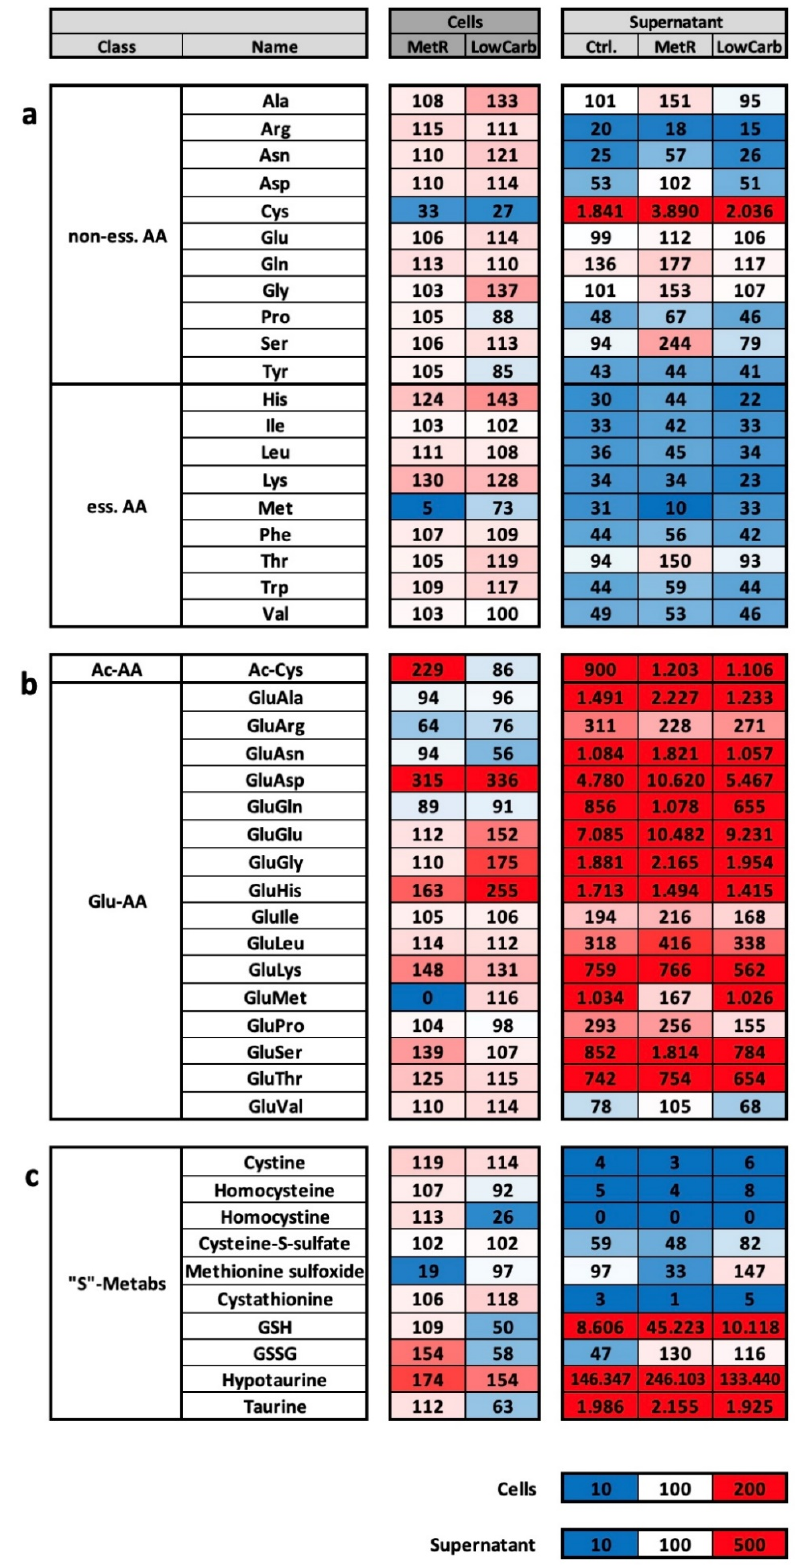
Figure 4. ( a – c ) Overview of metabolic classes and metabolic groups of liquid chromatography mass spectrometry of L929 cells in perfusion culture under MetR and LowCarb conditions. The metabolism of the murine cell line L929 was analysed via LC-MS in complete medium (control), MetR (0 mg/L), and Low Carb (3 mM glucose) for 7 days in a closed perfusion cell culture. After 7 days, the